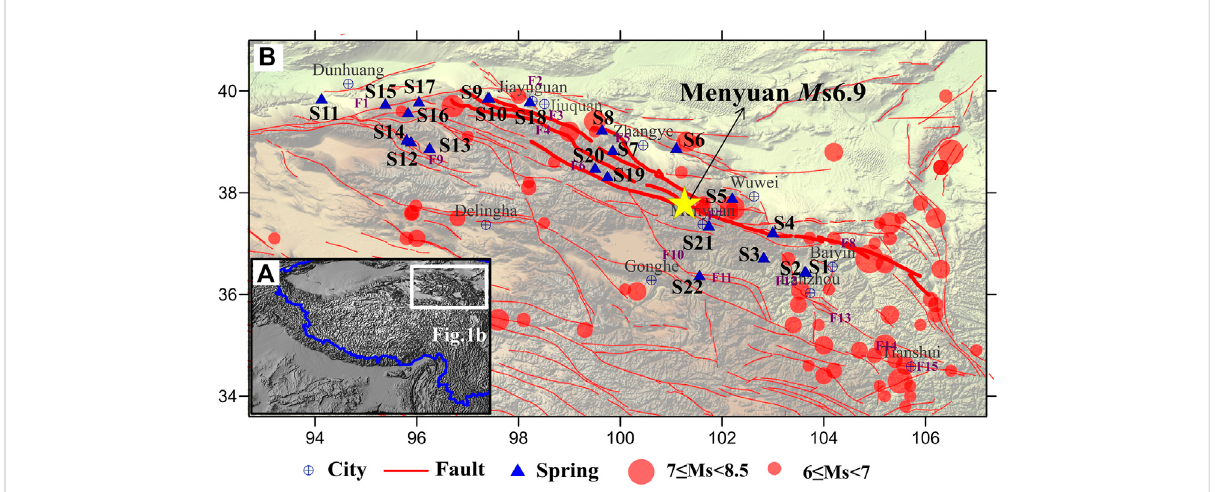
FIGURE 1 (A) Macro-regional map; (B) location of water sampling points and foci of large earthquakes (Ms > 6), along with major fault traces (F1: Altun Fault; F2: Jinta South Mountain Fault; North Edge Fault of Qilian Mountain; F4: Changma-Ebo Fault; F5: Yumu Mountain Fault; F6: Tuole Mountain Fault; F7: Lenglongling Fault; F8: Haiyuan Fault; F9: Danghe South Mountain Fault; F10: Riyue Mountain Fault; F11: Laji Mountain Fault; F12: ZhuanglangRiverFault;F13:MajieMountainFault;F14:TongweiFault;F15:FaultofnorthedgeofWestQinling.Thetimeof M s ≥ 6earthquakeis from BC780 to 12 January 2022 (Supplementary Table S1). The blue line in Figure 1a represents the borderline. The seismicity data came from the National Earthquake Data Center of China